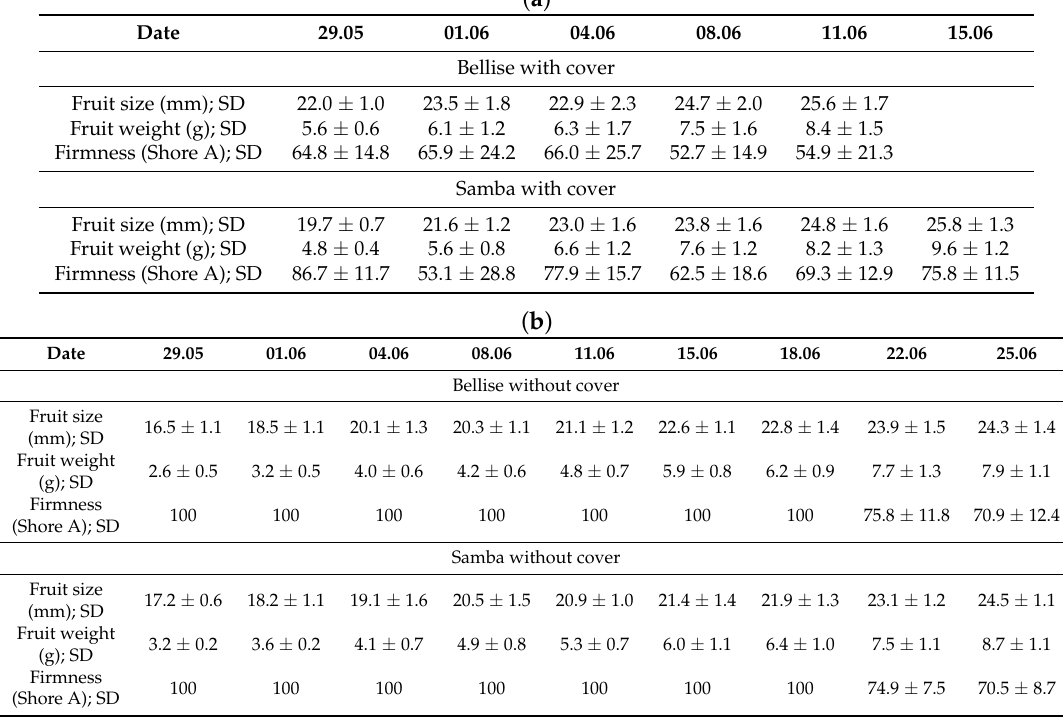
Table 1. ( a ) Fruit ripening parameters during maturation of sweet cherry cultivar “Samba” and “Bellise” with cover; n = 30, mean ± SD; ( b ) Fruit ripening parameters during maturation of sweet cherry cultivar “Samba” and “Bellise” without cover; n = 30, mean ±